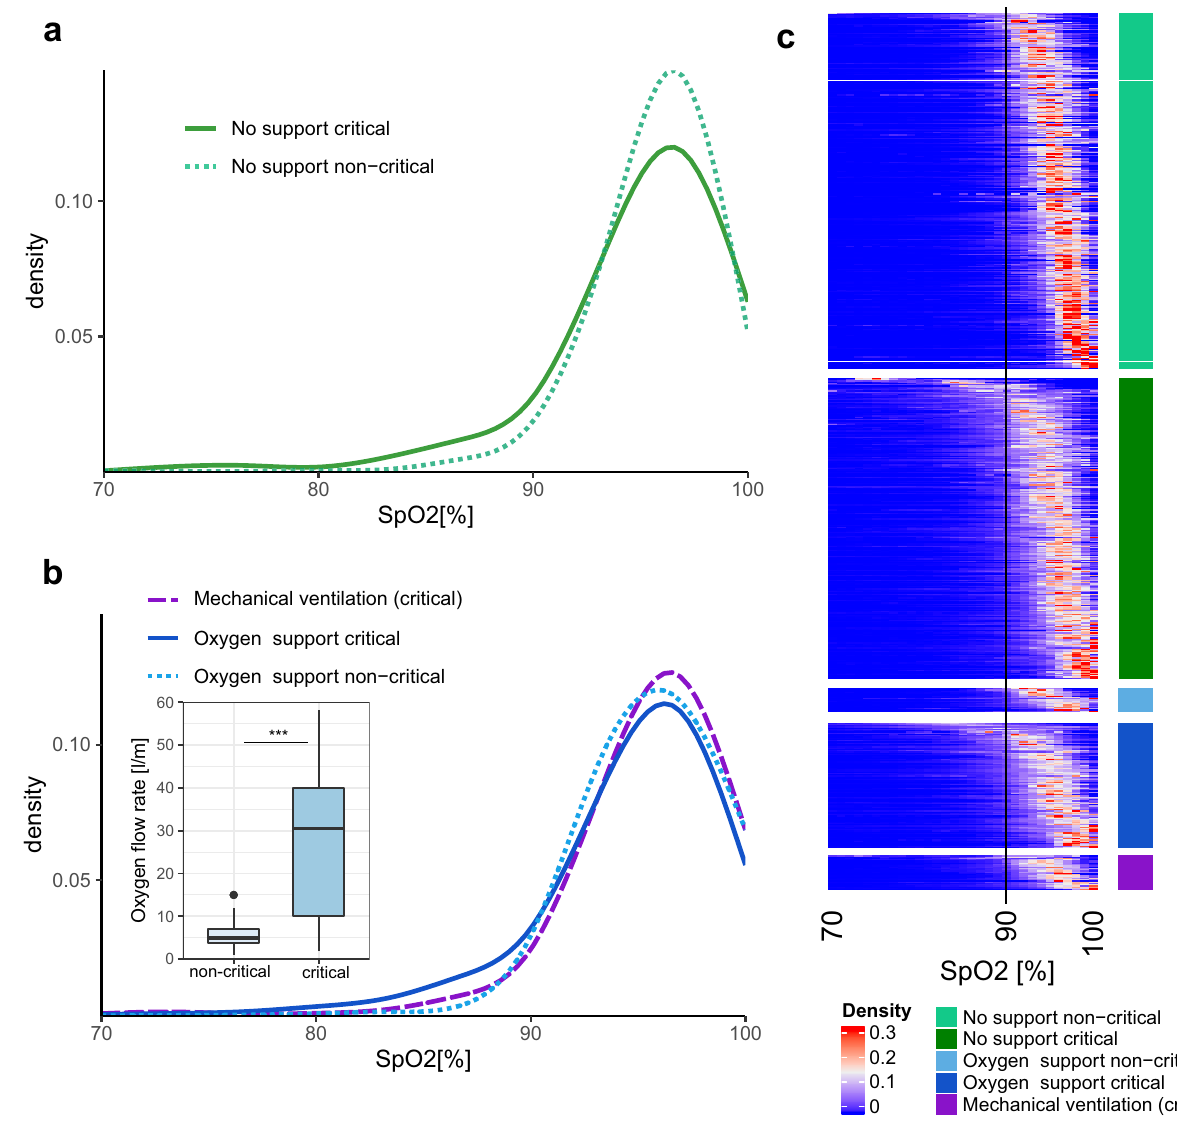
Figure 3. Global characteristics of SpO2 signal. ( a ) Density distribution of SpO2 for non-critical and critical patients without support. ( b ) Density distribution of SpO2 from non-critical and critical patients for intervals under oxygen support or mechanical ventilation (see Figure S1 and oxygen and mechanical ventilatory support section). The level of oxygen support (oxygen flow rate) was compared between non-critical and critical patients. The center of boxplot indicates the median, and the bottom and top edges indicate the 25th and 75th percentiles, points indicate outliers. ( c ) SpO2 density heatmap for each interval of SpO2 signal of patient in each group. A vertical black line represents the threshold of 90% SpO2 recommended in the WHO guidelines 5 to identify severe